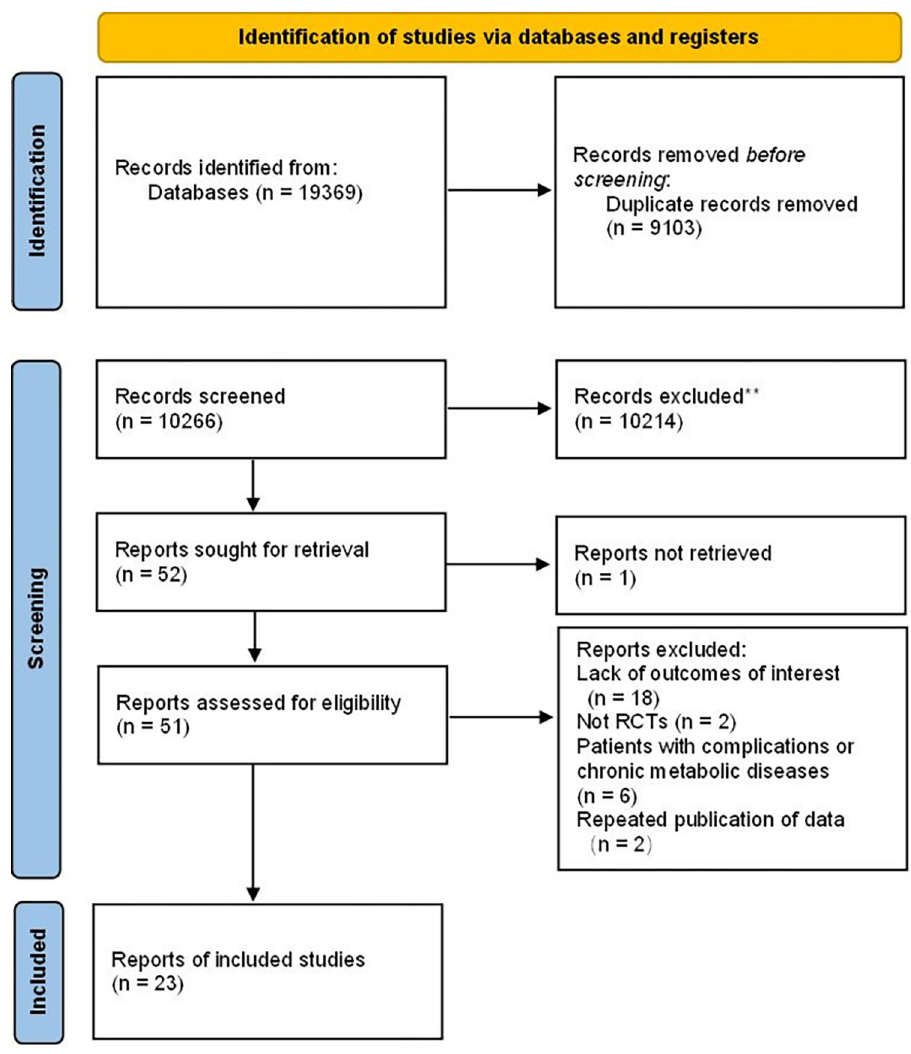
Fig 1. Flow chart of literature screening and the selection